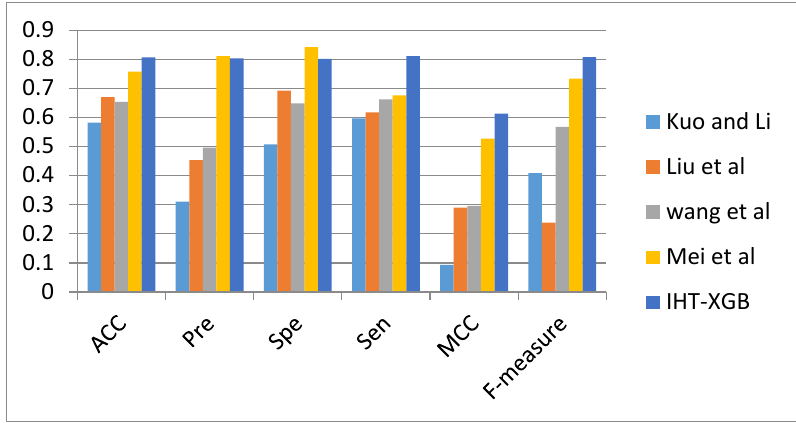
Figure 2. Prediction performance comparison of IHT-XGB method with four previous works.